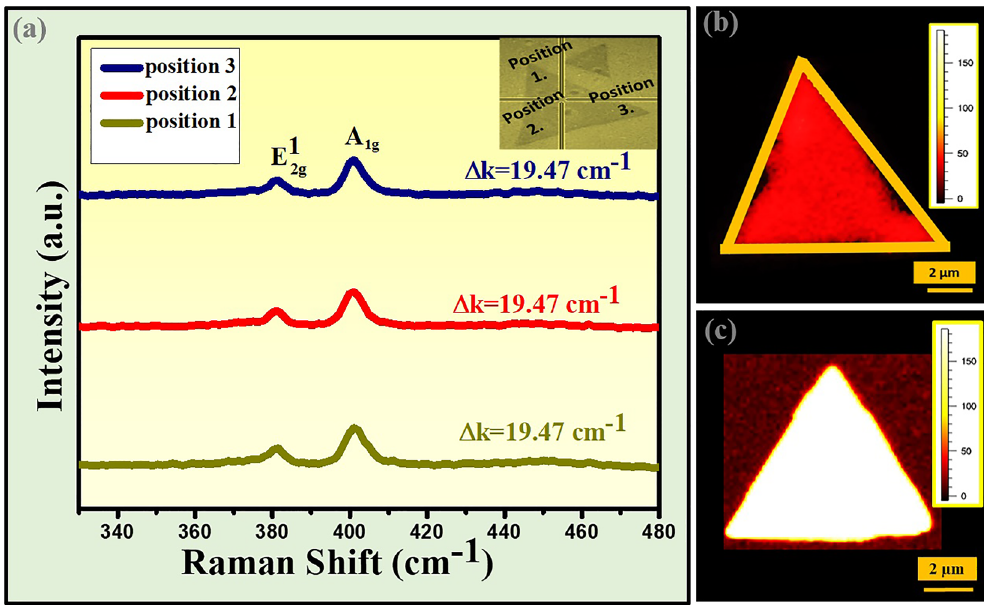
Figure 3. Raman spectra and Raman mapping. ( a ) Raman spectra of triangular shaped monolayer MoS 2 on 300 nm thick SiO 2 /Si substrate at three of its corners represented with their frequency difference of in and out of plane vibration modes. Raman mapping of triangular shaped monolayer MoS 2 with respect to vibrational peak intensity. ( b ) In plane E 1 2g . ( c ) Out of plane A 1g, scale bar is mentioned.